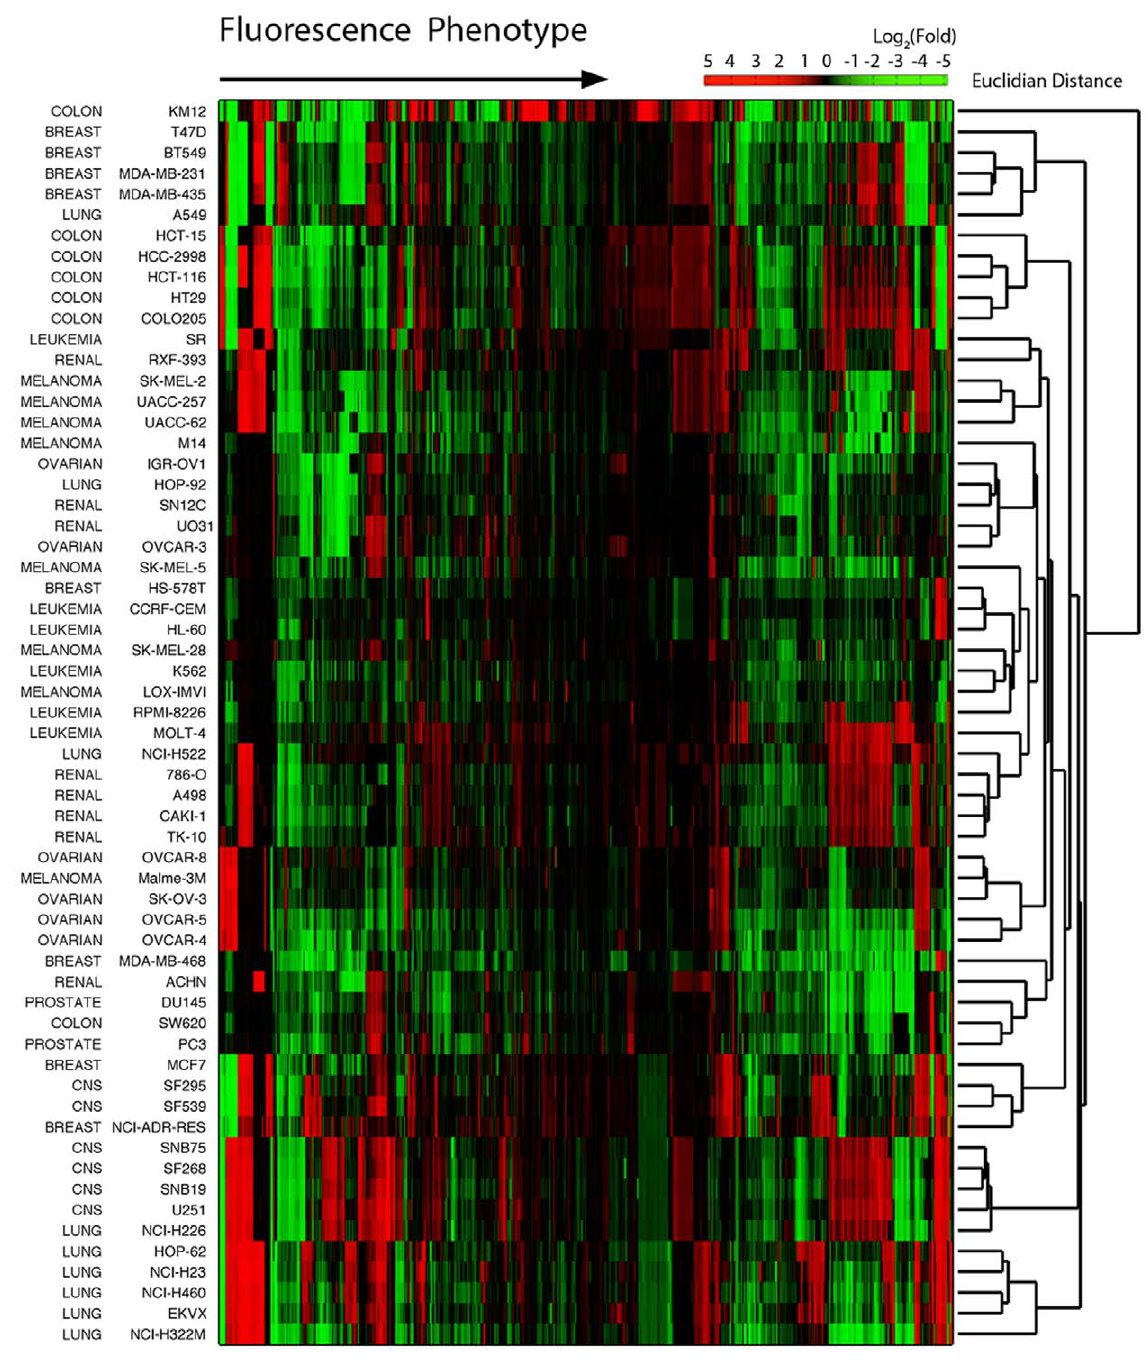
Figure 2. Hierarchical clustering of the fluorescence response phenotype. Fluorescence intensity fold changes were clustered for the 557 fluorescent probes (x-axis) across the 60 cancer cell lines (y-axis). Fold=(fluorescence intensity at 48 h incubation)/(fluorescence intensity at 1